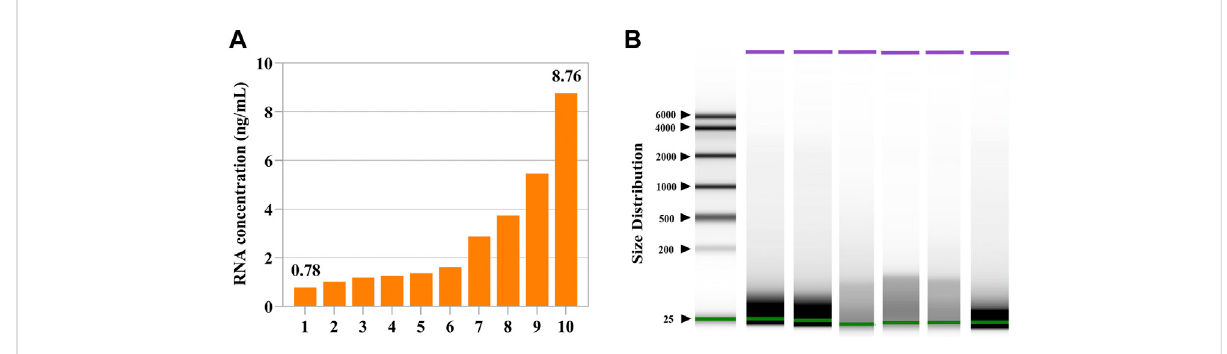
FIGURE 1 Concentrations and fragments of cell-free RNAs in the human follicular fl uid. (A) Measured concentrations of cell-free RNAs in ten follicular fl uids. (B) Fragment distributions of cell-free RNAs in six follicular fl uids. Nearly all detected cell-free RNAs were within the size range of 20 – 200